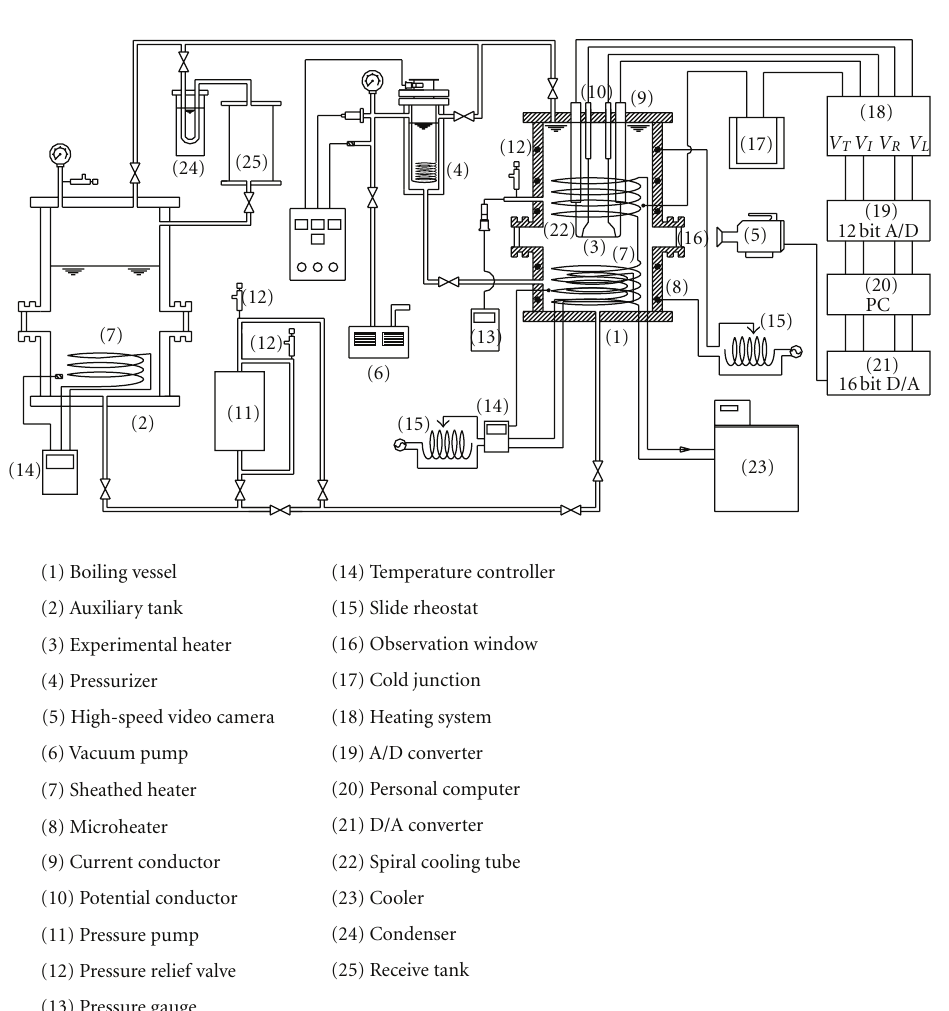
Figure 1: Schematic diagram of experimental apparatus.